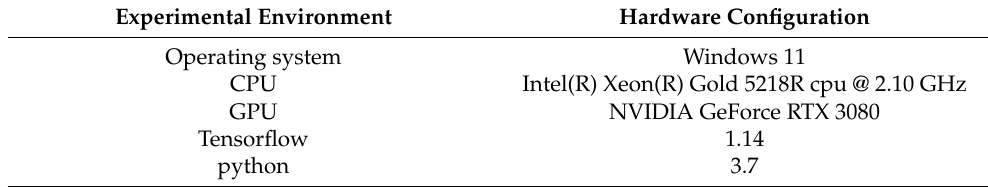
Table 2. Experimental environment setting.